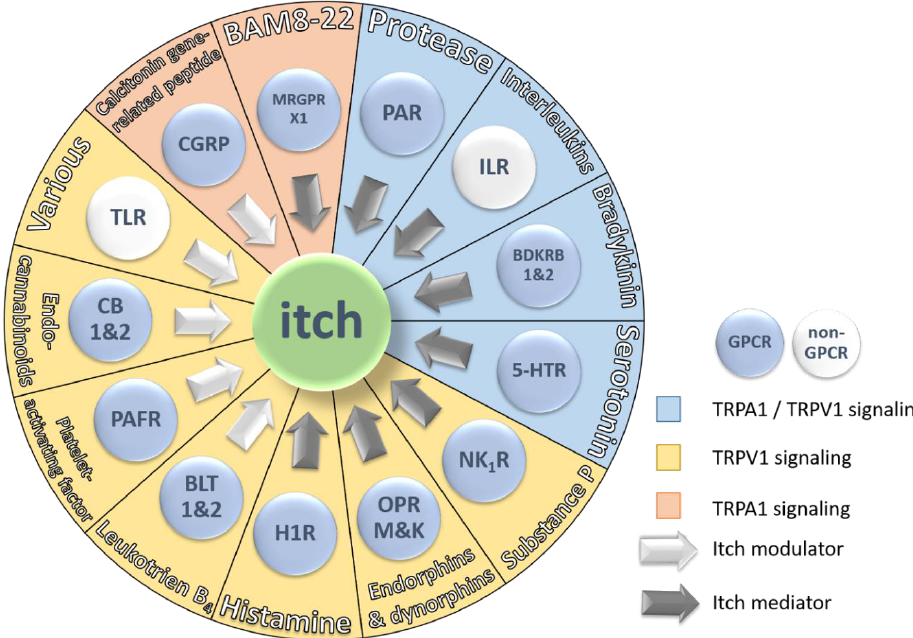
Figure 3. Schematic representation of the 13 major receptor groups involved in itch and their endogenous pruritogens. Each receptor is colored based on two parameters: First, GPCR signaling (blue button) or non-GPCR signaling (white button) and second, ion channel signaling pathway. TRPA1/TRPV1 signaling is represented by a blue sector, TRPV1 signaling is represented by a yellow sector and TRPA1 signaling is represented by an orange sector. The arrows indicate the type of contribution of the receptor and its endogenous pruritogens to itch sensation. White arrows represent itch modulators and grey arrows represent itch mediators.